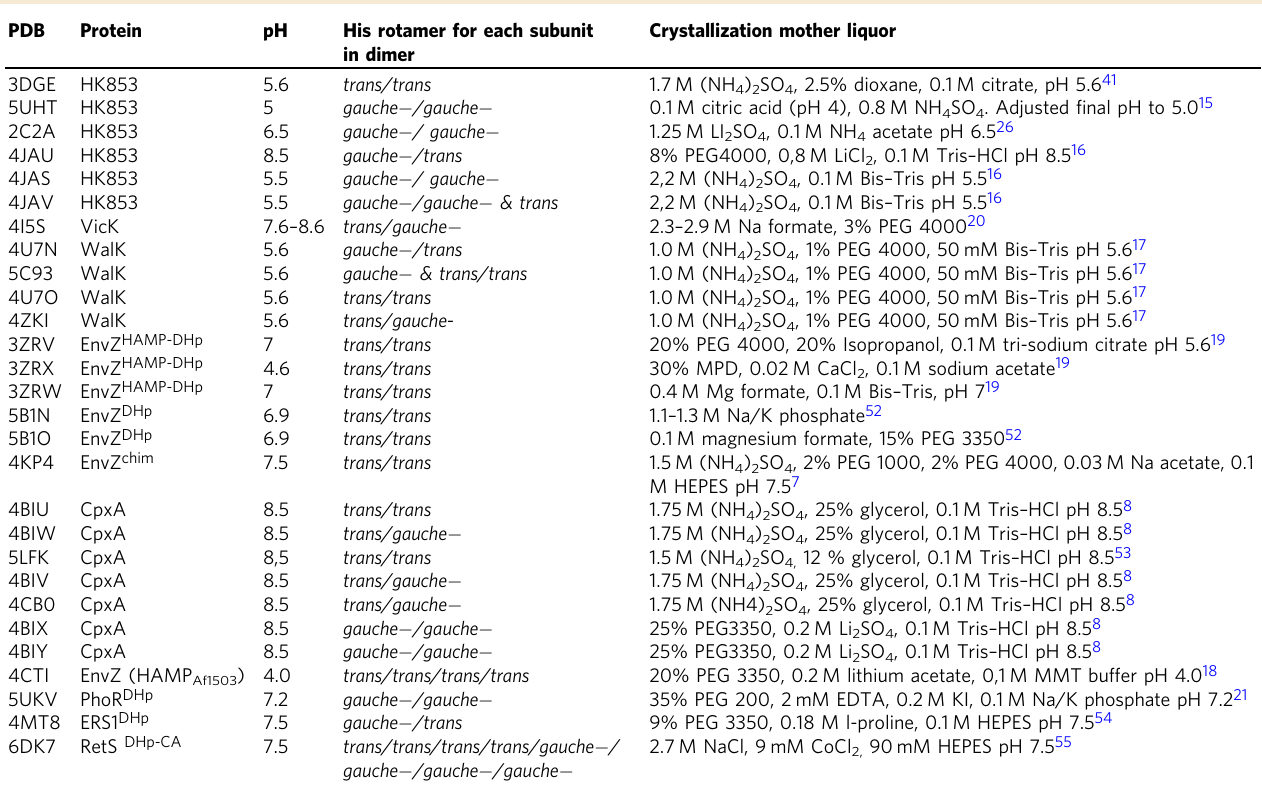
Table 1 His rotamer disposition for HisKA HKs deposited at the PDB. PDB Protein pH His rotamer for each subunit Crystallization mother in dimer